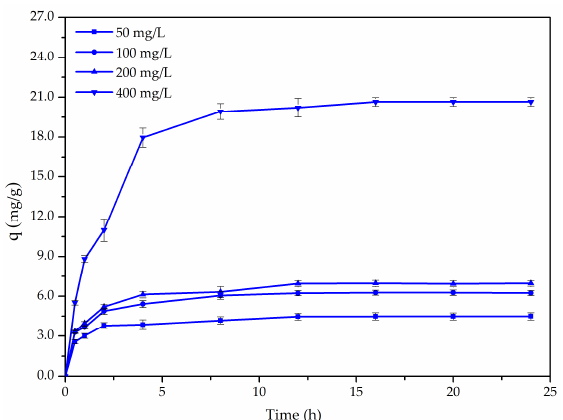
Figure 6. Effects of initial concentrations and time on the adsorption capacity (pH = 5, T = 25 °C, n = 100 rpm).